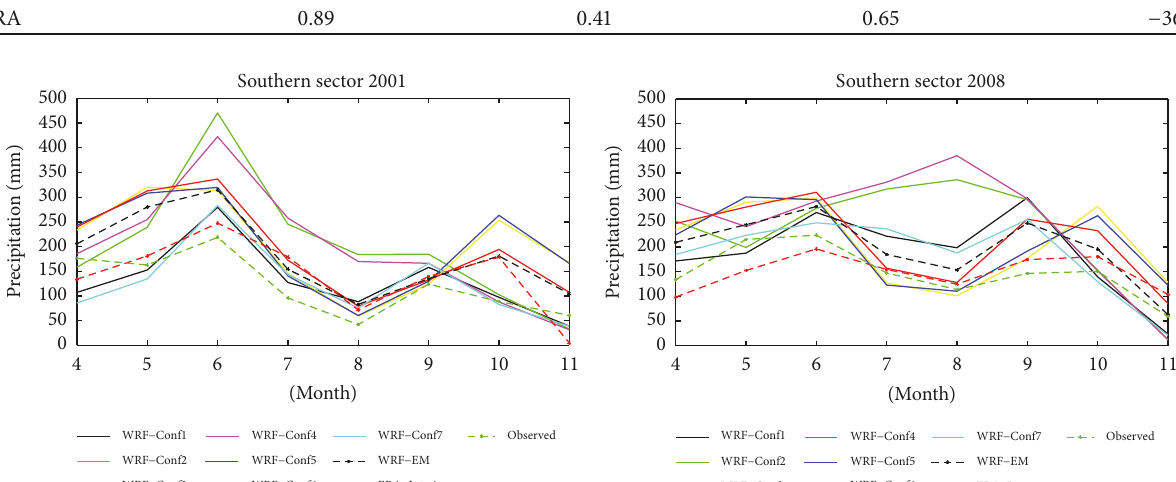
Figure 9: Time series plots of monthly total precipitation simulated for the southern sector of Ghana for the dry year (2001) and wet year